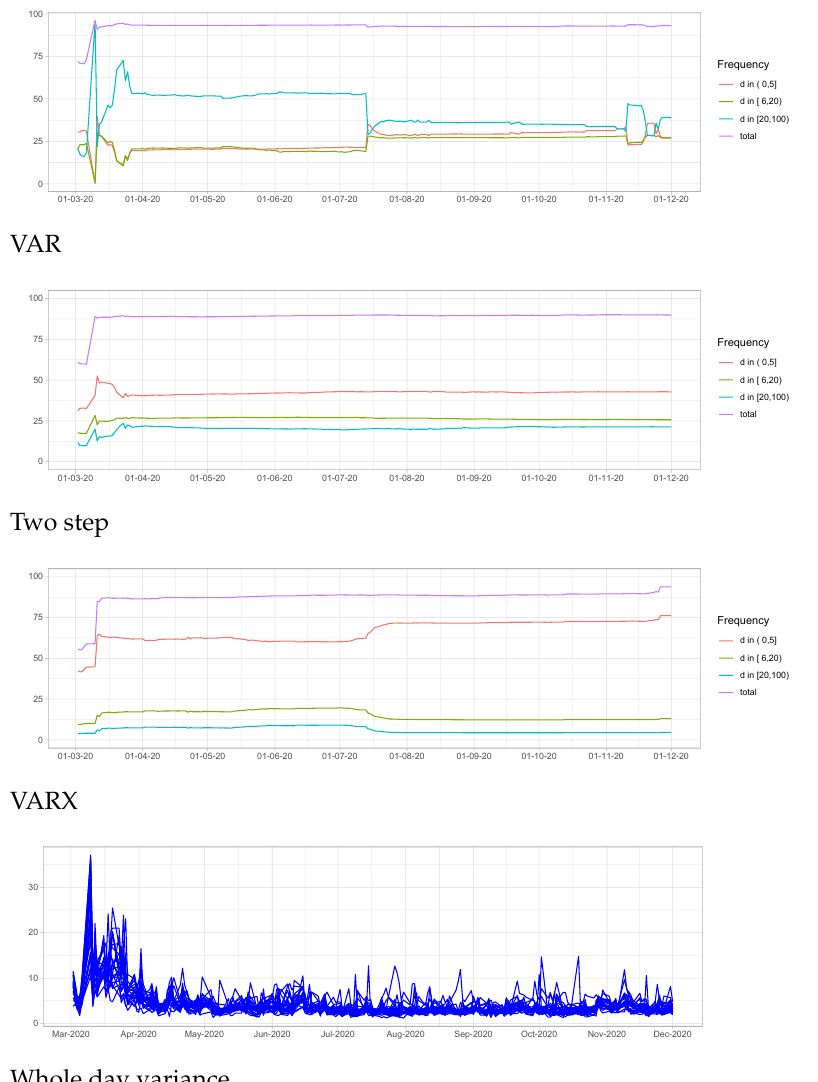
Figure 8. Dynamic frequency connectedness during period of crisis 2020. Next, we will consider the evolution of the frequency decomposition for the period of the political and economic crisis of 2014 in Russia (Figure 9). The addition of oil and gold price level to exogenous variables did not practically change the interconnection in this time period. One may note that Black Monday (3 March 2014, marked with a dotted line), associated with the political situation in the country, led to an increase in connectivity. At the same time, a more significant jump in medium and long-term connectivity was observed during the period of falling oil prices (from 20 June 2014 to 1 April 2015, marked with dashed